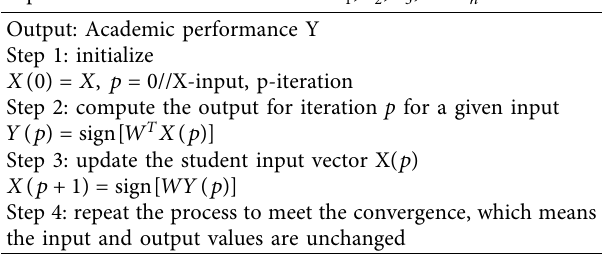
Table 2: Steps for associative memory network output